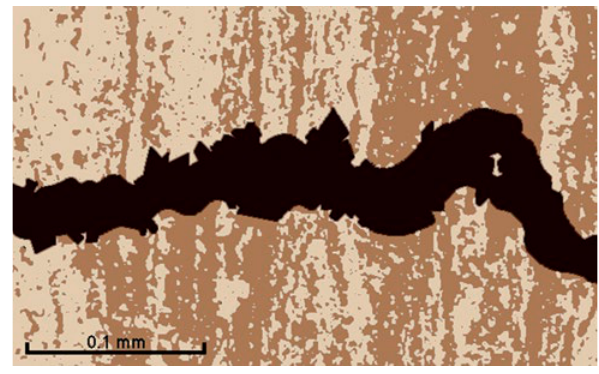
Figure 79. A ptygmatic micro-veinlet of magnetite (black) cutting chert (white) and hematite (grey) bands is from the Mary Ellen Mine, Biwabik, Minnesota. The magnetite octahedra projecting across the veinlet boundary clearly indicate that crystallization is later and that the magnetite had an intrusive non-crystalline pre- cursor with shear thinning properties as indicated by the ptygmatic folding. A thixotropic ferric hydroxide vein precursor is unmistak- ably indicated. (From Lougheed 4 , 1983, p. 339.)